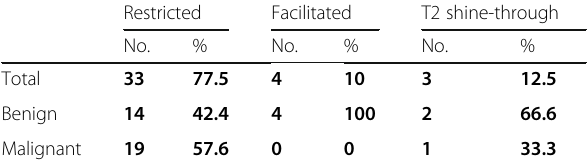
Table 2 Characterization of the lesion in the benign and malignant groups in diffusion images using qualitative assessment